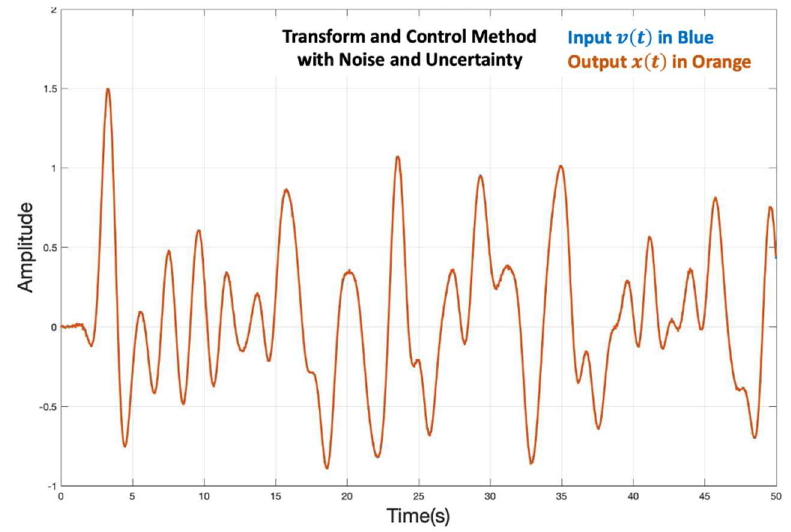
Figure 26. Impact of Noise and Uncertainty (New Method) .